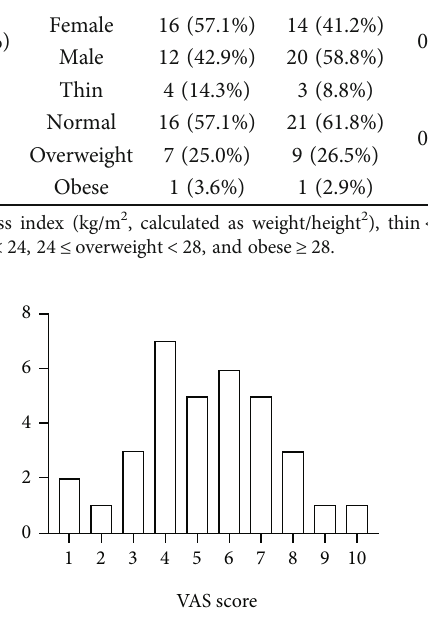
Figure 1: Abdominal pain severity of the IBS-D patients. VAS: visual analogue